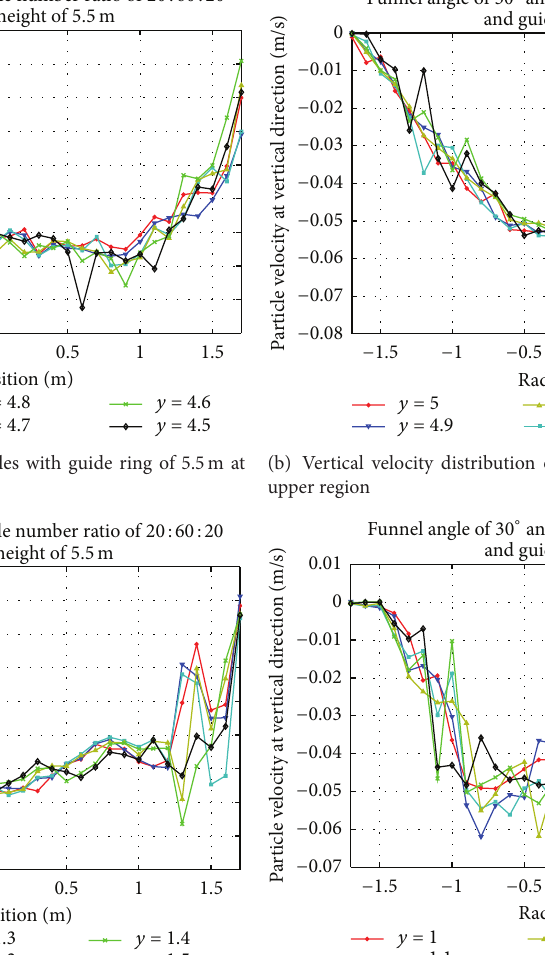
(d) Verticalvelocitydistributionofpebbleswithguideringof6matlower region mFunnel angle of 30 ∘ and pebble number ratio of 20 : 60 : 20 and guide ring height of 6